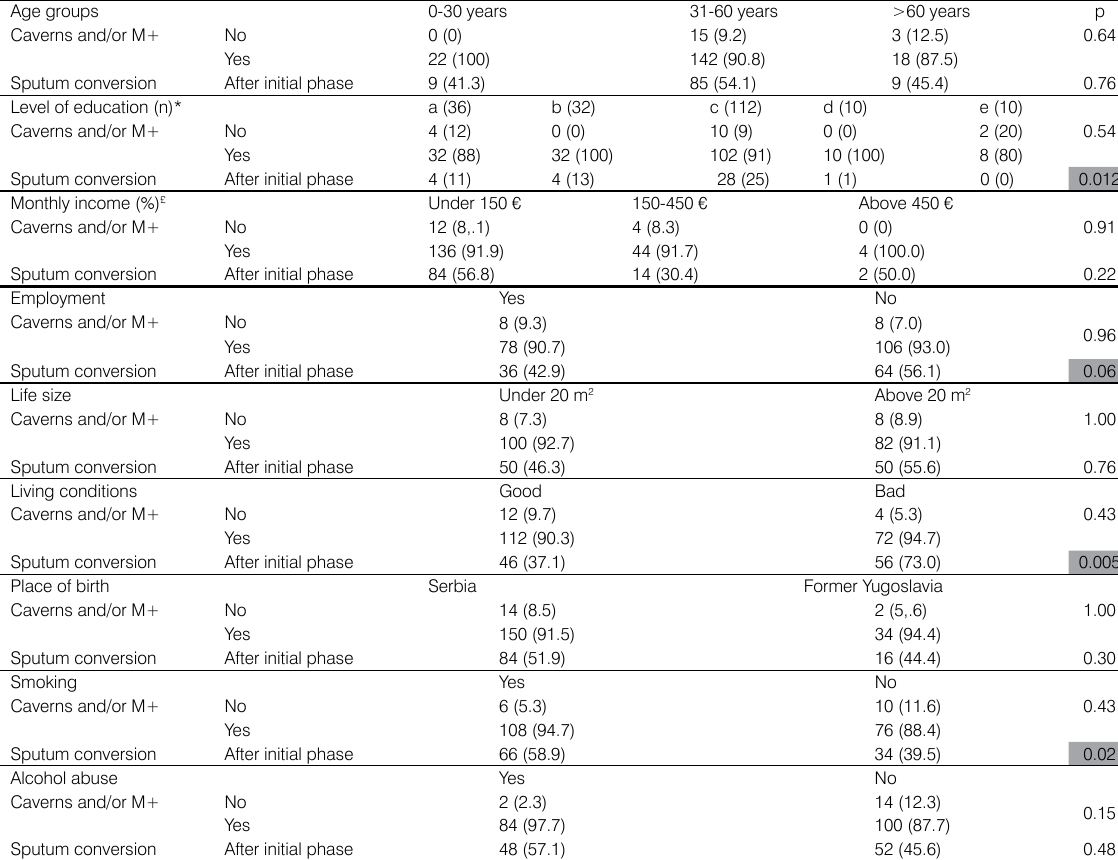
Table 3. Comparison between parameters (age group, education, financial, employment, living area and condition, place of birth, poor habits) to radiographic findings (caverns) and conversion of sputum (n, %, p)